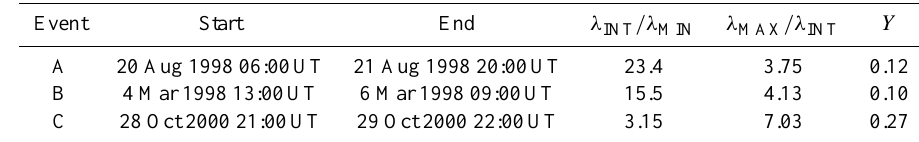
Table 1. Start and end times of three examples of classic magnetic clouds selected from the Cane and Richardson (2003) ICME list. λ INT /λ MIN and λ MAX /λ INT are the ratios of magnetic field variances in the variance directions. Y is the closest approach of the observing spacecraft to the flux rope axis inferred from a flux rope model fit.